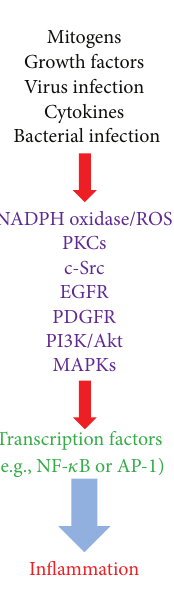
Figure 2: The signaling pathways in airway and pulmonary inflam- mation. Various stimuli, such as mitogens, growth factors, virus infection, cytokines, and bacterial infection, can induce inflamma- tion via the NADPH oxidase/ROS, PKCs, c-Src, EGFR, PDGFR, PI3K/Akt, and MAPKs pathways and the transcription factors, such as NF- 𝜅 B and AP-1 in lung resident